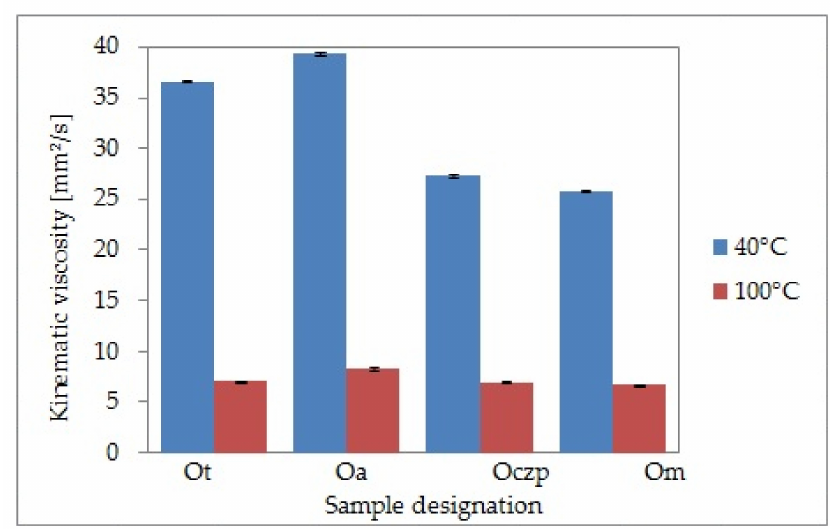
Figure 1. Kinematic viscosities of the tested oils at 40 ◦ C and 100 ◦ C. Ot = strawberry seed oil,